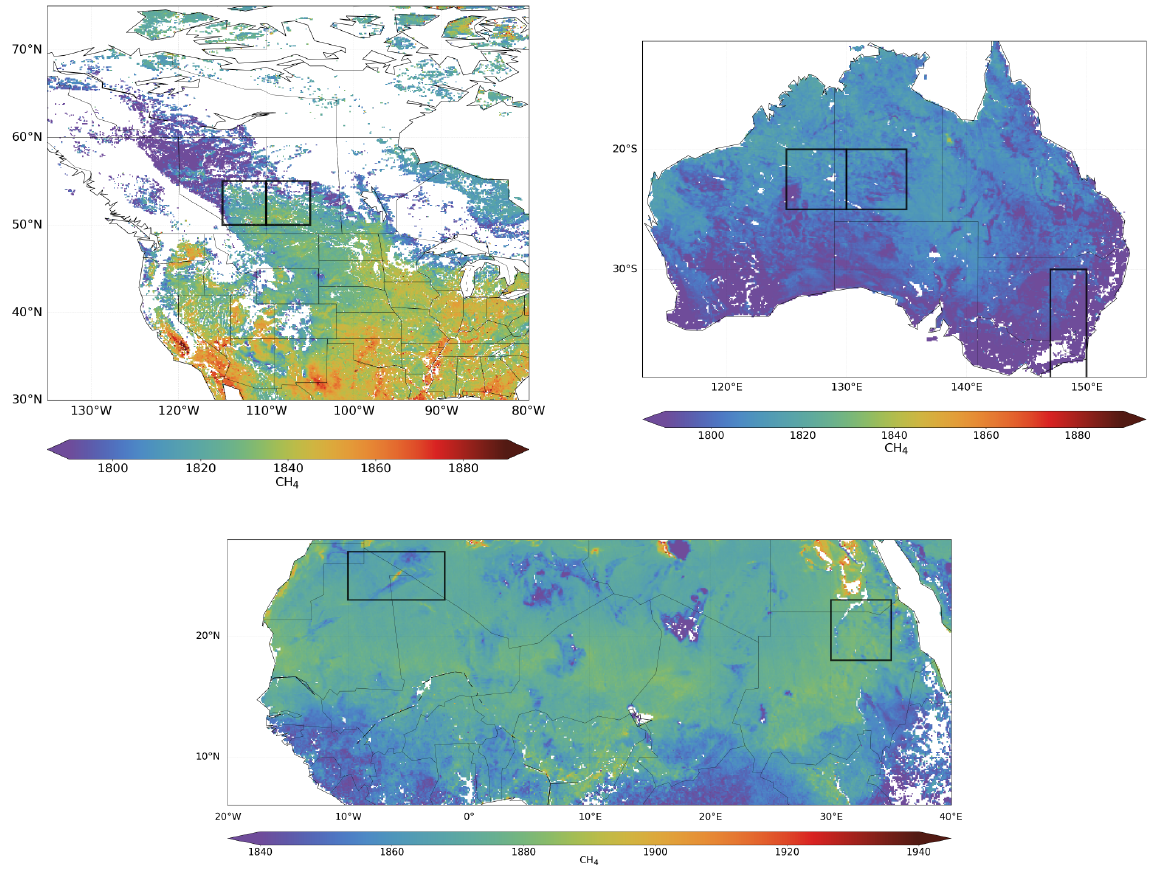
Figure B1. Black boxes over North Africa, Australia and Canada correspond to the different regions selected to estimate the a posteri- ori correction (see Sect. 3.4). Global distribution of XCH 4 averaged to a 0.1 ◦ × 0 . 1 ◦ grid for the period 1 January 2018–31 December